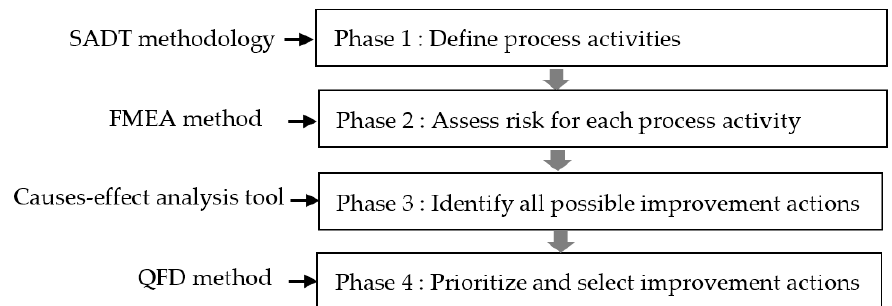
Figure 1. Flowchart of the proposed approach.